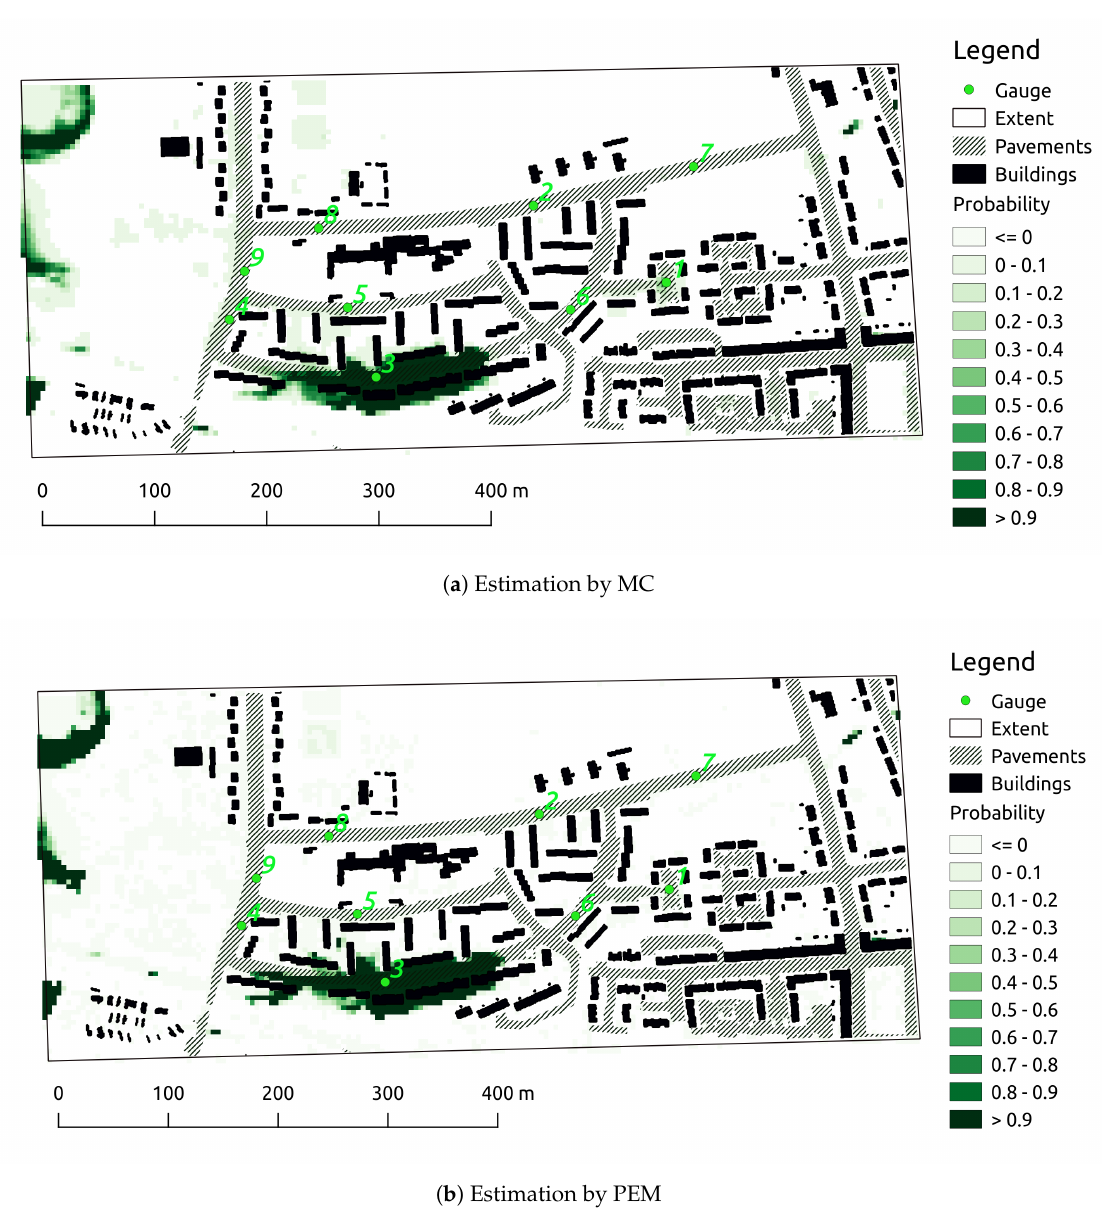
Figure 9. Probabilistic inundation maps showing the probability of inundation over 0.2